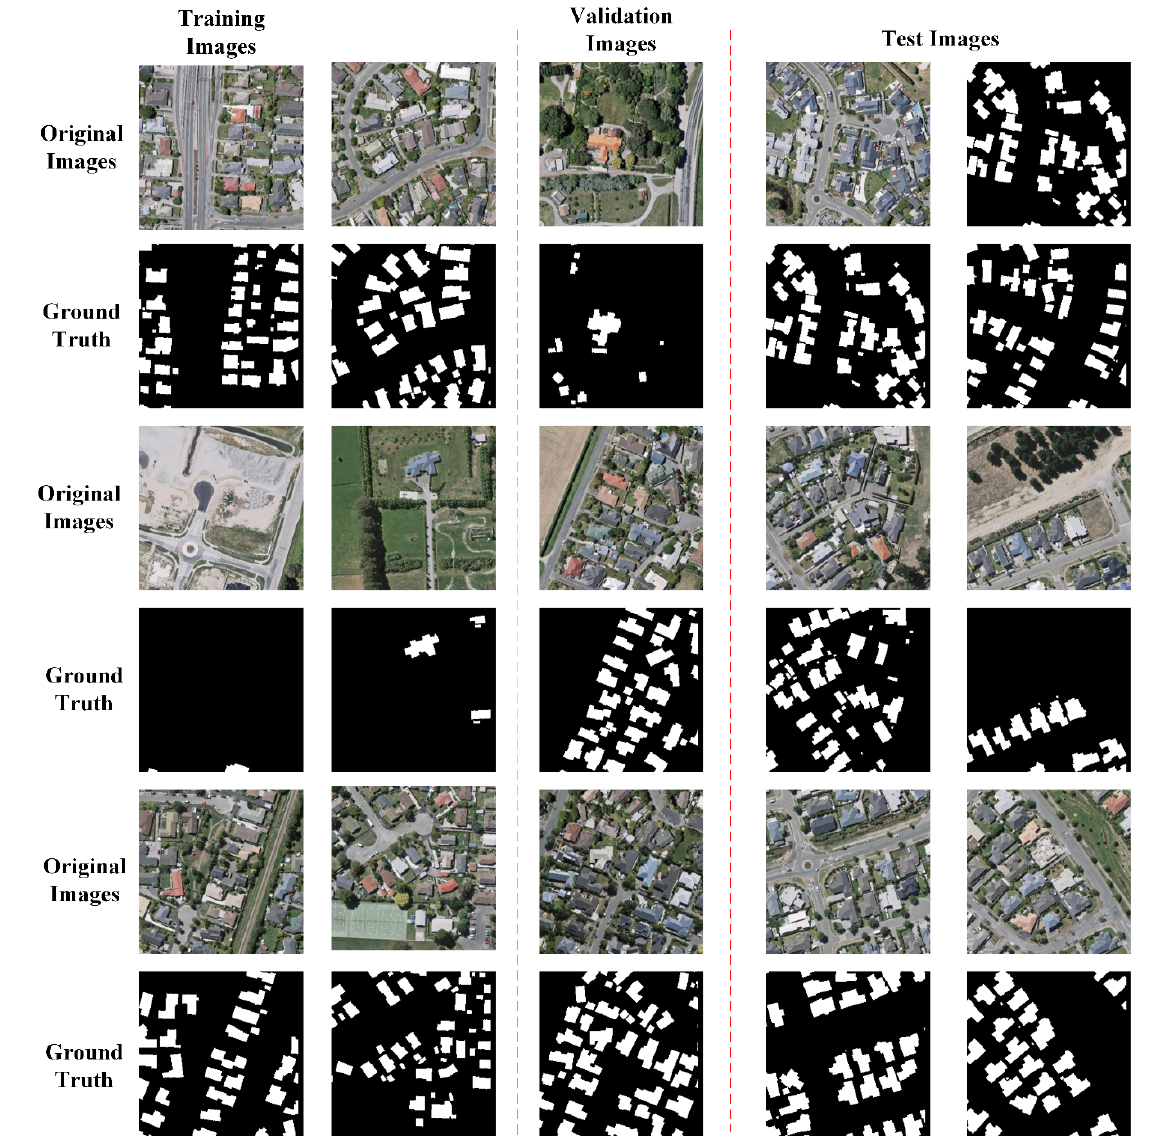
Figure 1. Several training, validation and testing sample images in the WHU building dataset.